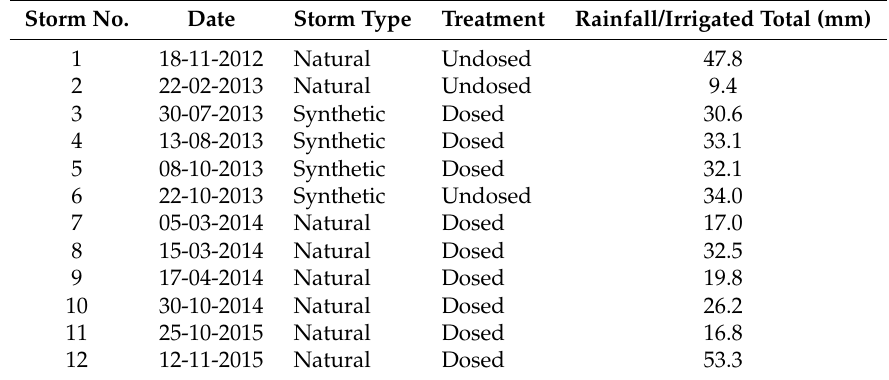
Table 1. List of storm dates, rainfall totals, and the type of pollutant load. Dosed events are those where spiked analyte solution was applied to the pavements prior to a storm. Synthetic storms were artificial events generated through the application of irrigation water to the pavements. Storm